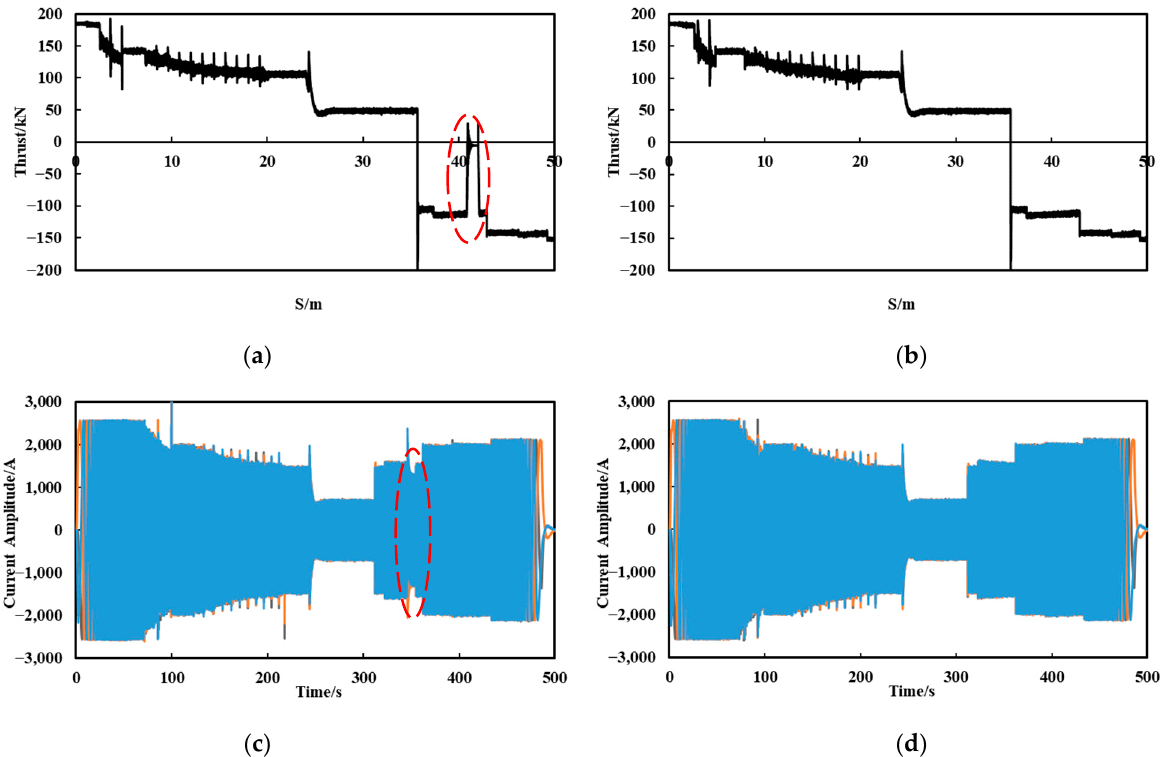
Figure 12. The current and thrust force of LLSM at two sides when the fault occurs during deceleration process: ( a ) thrust of the fault side LLSM; ( b ) thrust of the normal side LLSM; ( c ) current of the fault side stator segment; ( d ) current of the normal side stator segment.